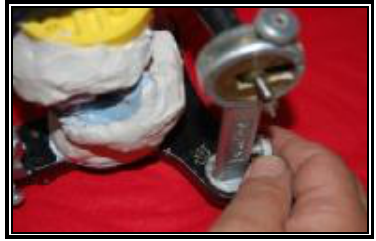
Figure 4a: Condylar Post Setting For Estimating Bennett Angle.